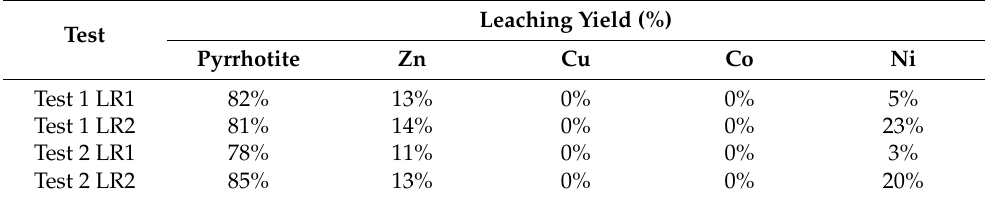
in continuous mode tests.